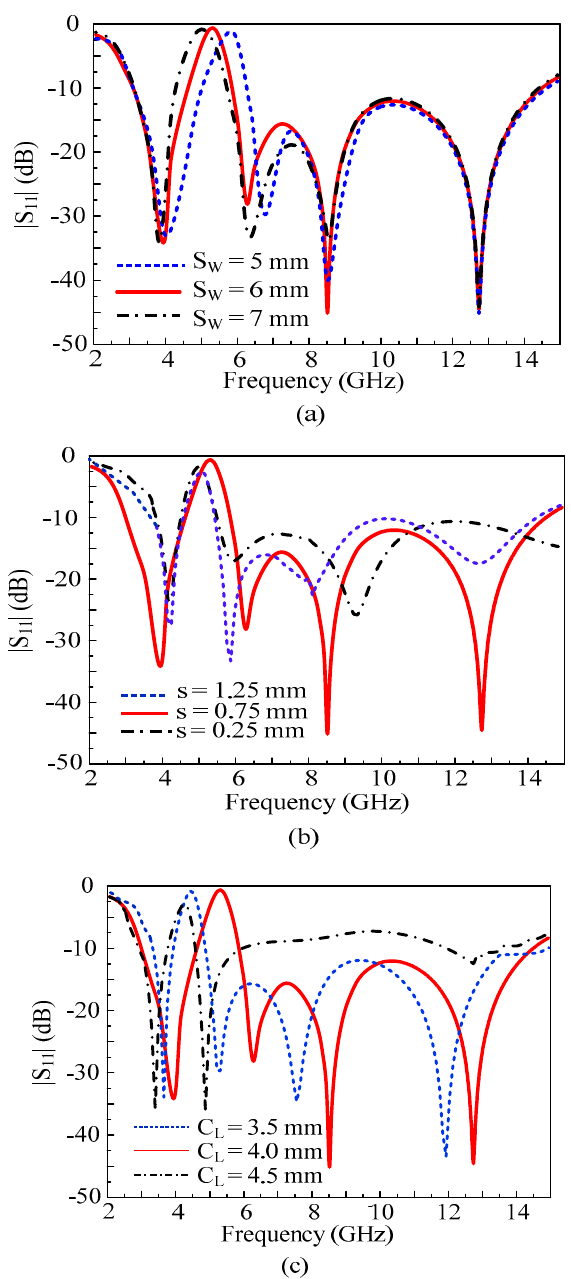
Figure 3. |S 11 | of the antenna for di ff erent values of ( a ) S W , ( b ) s, ( c ) C L .